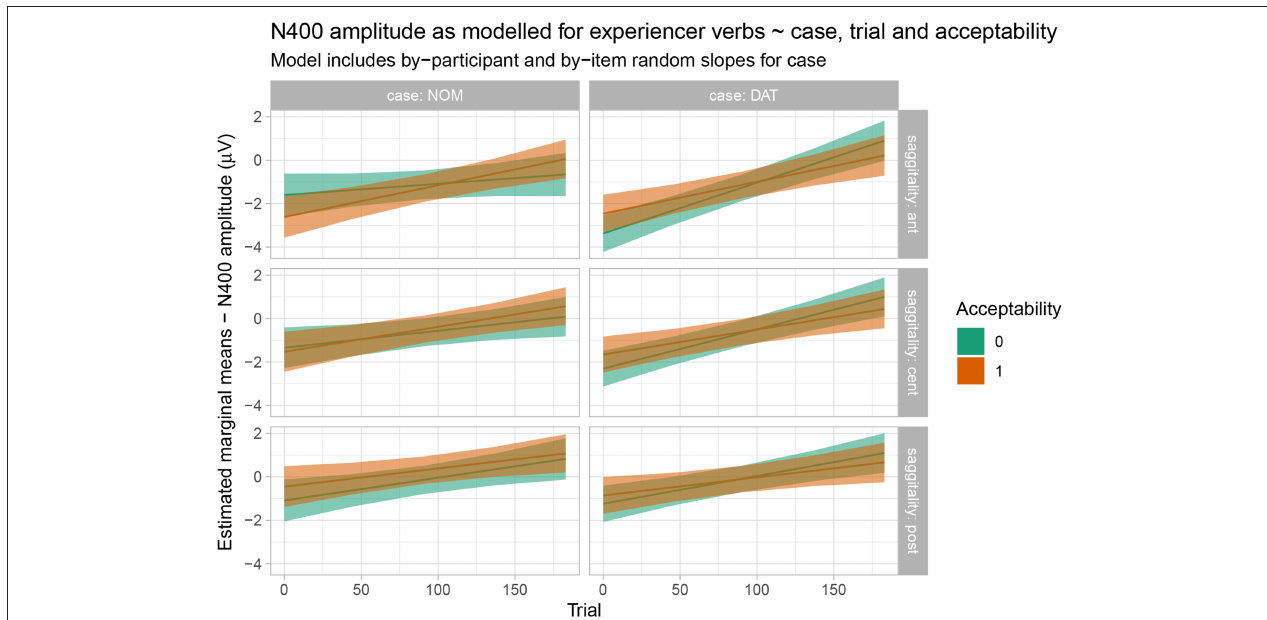
FIGURE 8 | Estimated marginal means for the response-contingent analysis of the experiencer verb data in the N400 time window. Shaded regions indicate 83% confidence